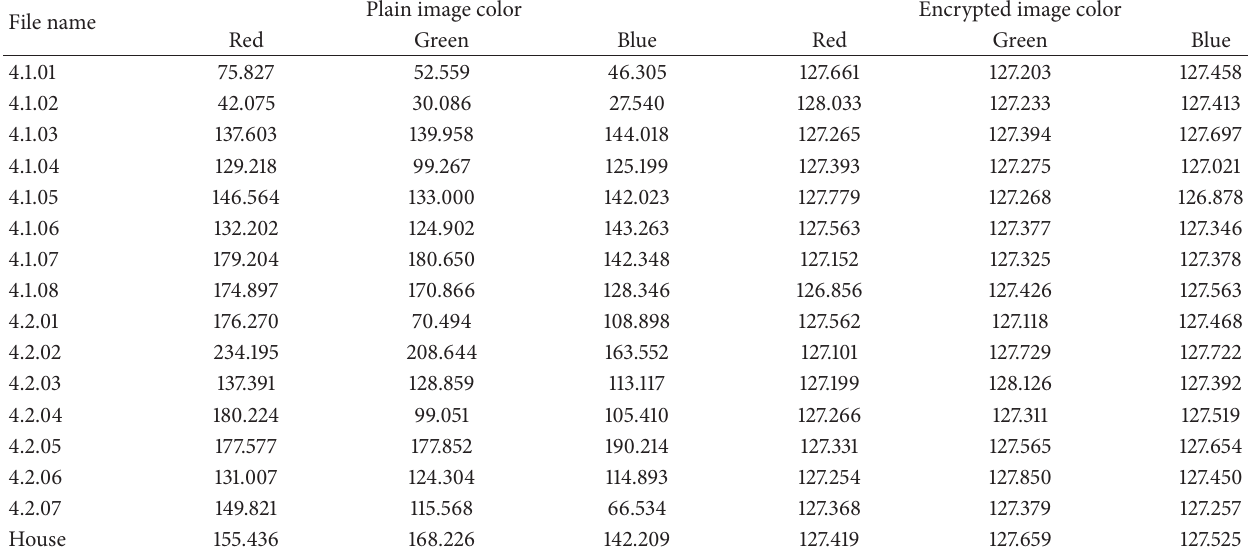
Table 4: Average pixel intensity of plain image colors and encrypted image colors.